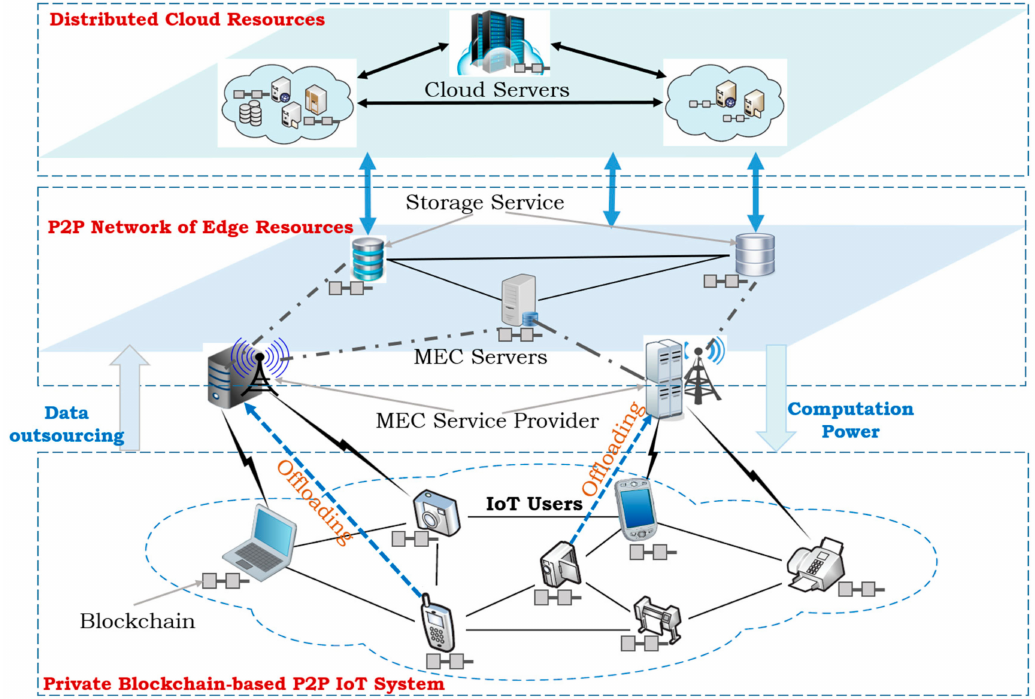
Figure 4. Blockchain-based IoT framework with edge computing.